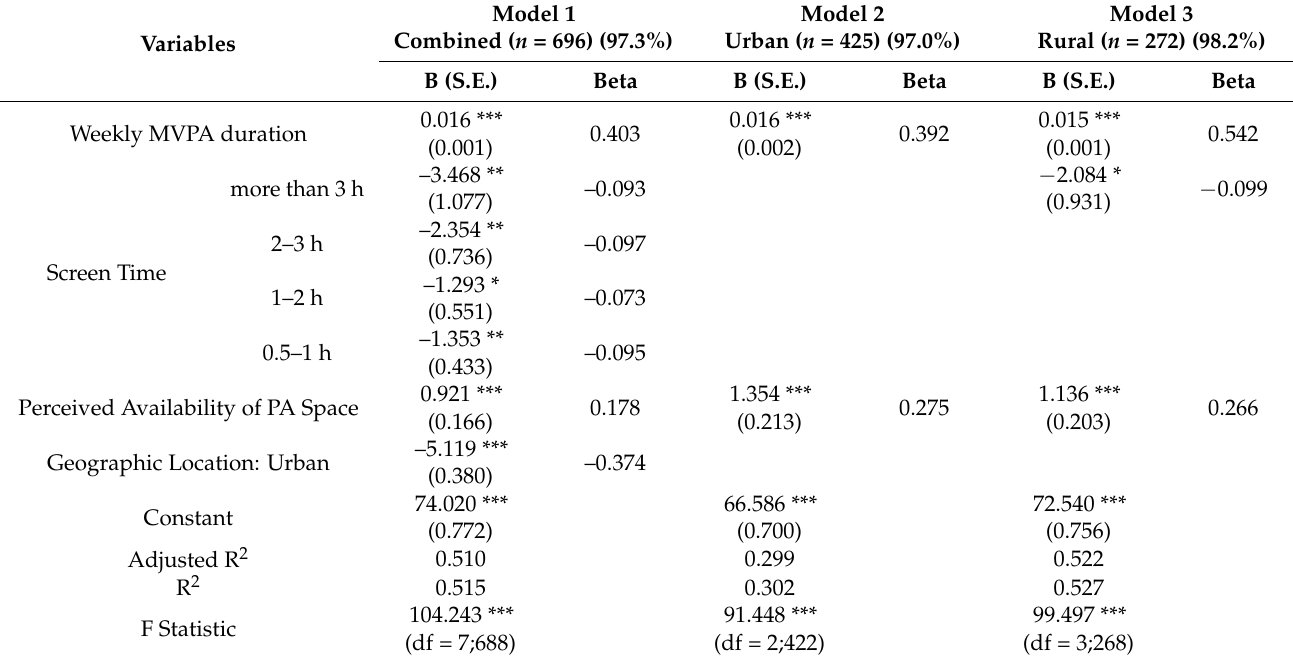
Table 8. Variables Predicting PFI: Results from Multiple Linear Regression